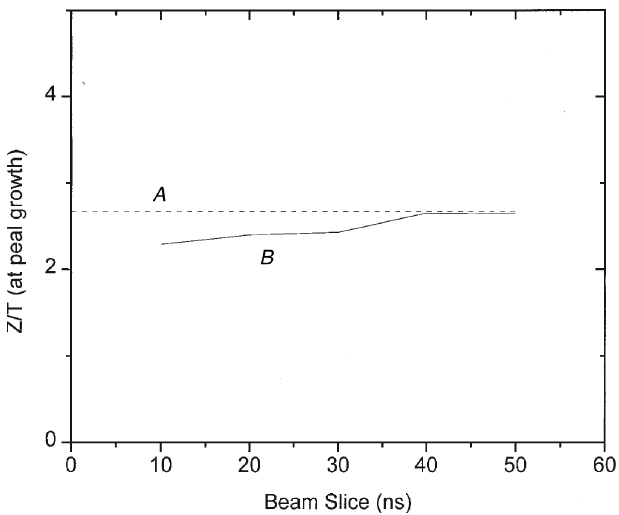
FIG. 4. Same as Fig. 2 for Lorentzian channel conductivity profile.